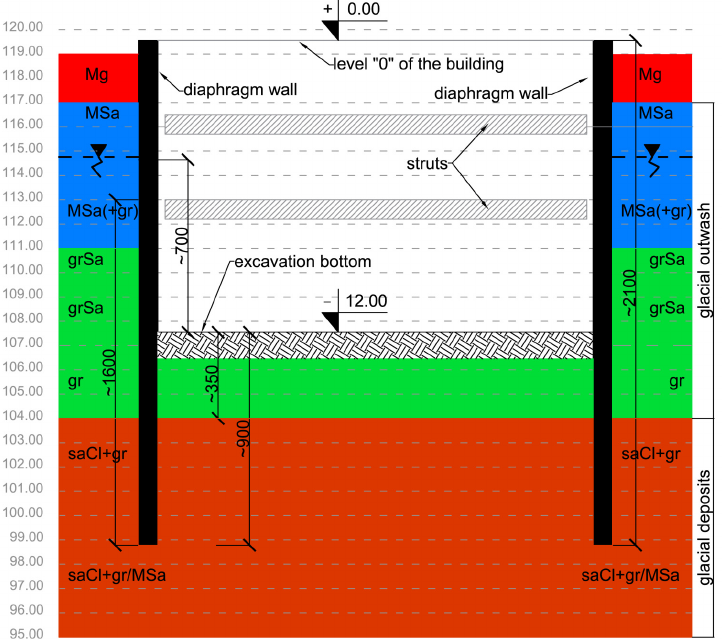
Figure 5. Diaphragm walls supported by struts the cross-section of the excavation and geotechnical